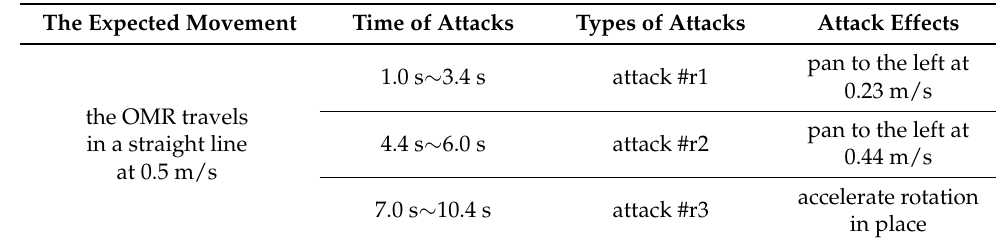
Figure 6. The situation when the OMR is subjected to replay attacks. ( a ) The real ˙ x of the OMR and the expected commands ˙ x c ; ( b ) the real ˙ y of the OMR and the expected commands ˙ y c ; ( c ) the real ˙ θ of the OMR and the expected commands ˙ θ c . Table 2. The description and duration of replay